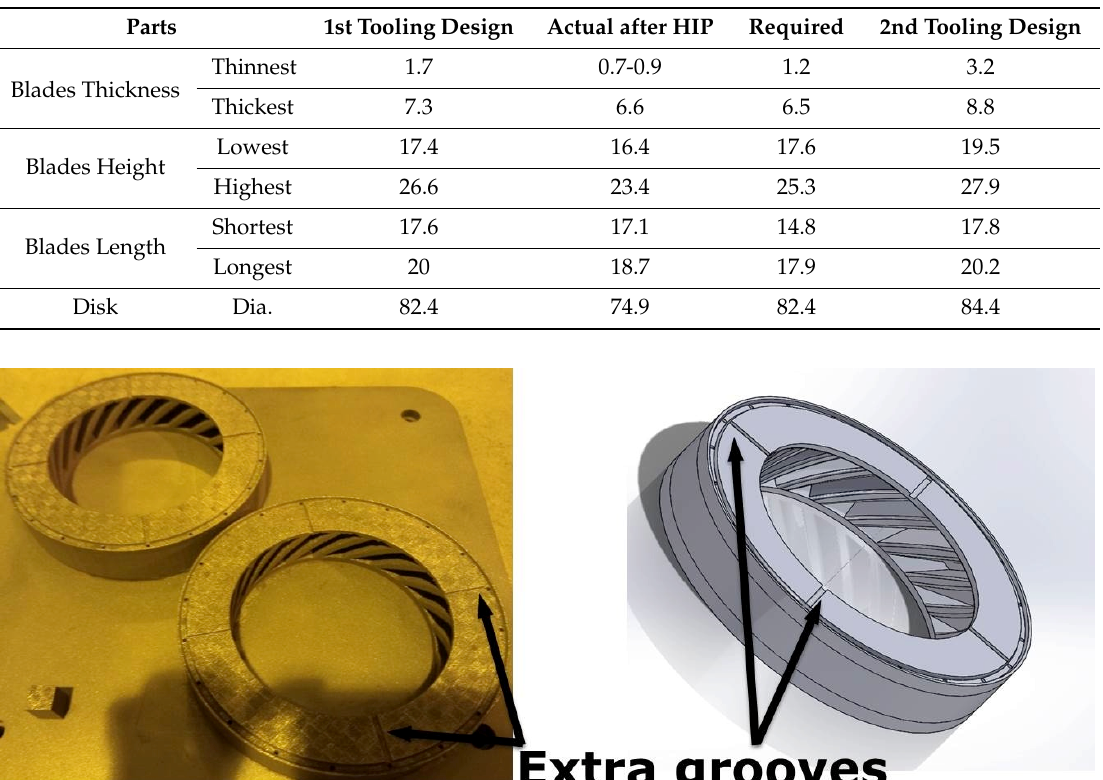
Table 3. The size comparisons of di ff erent parts of blisk (dimensions in mm).